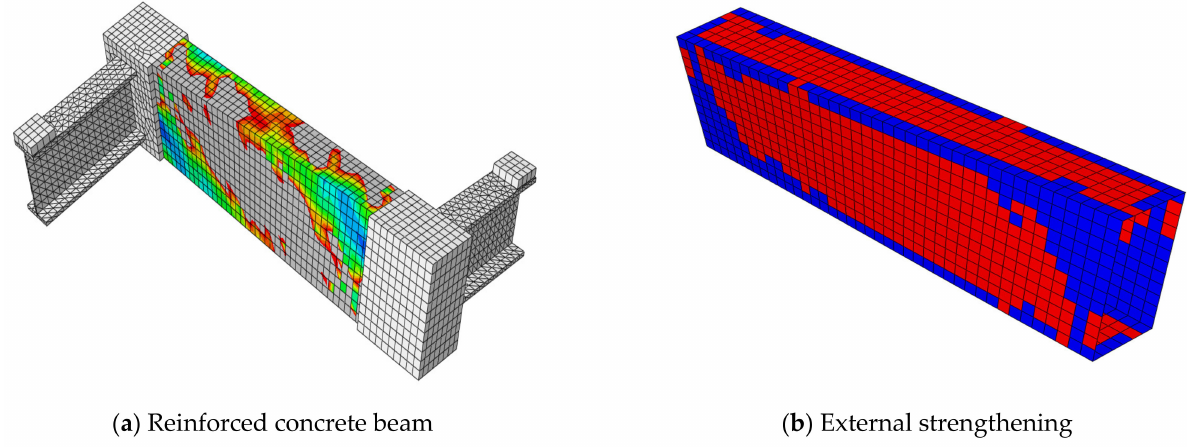
Figure 33. FE final cracks of beam B4-1SM at the ultimate